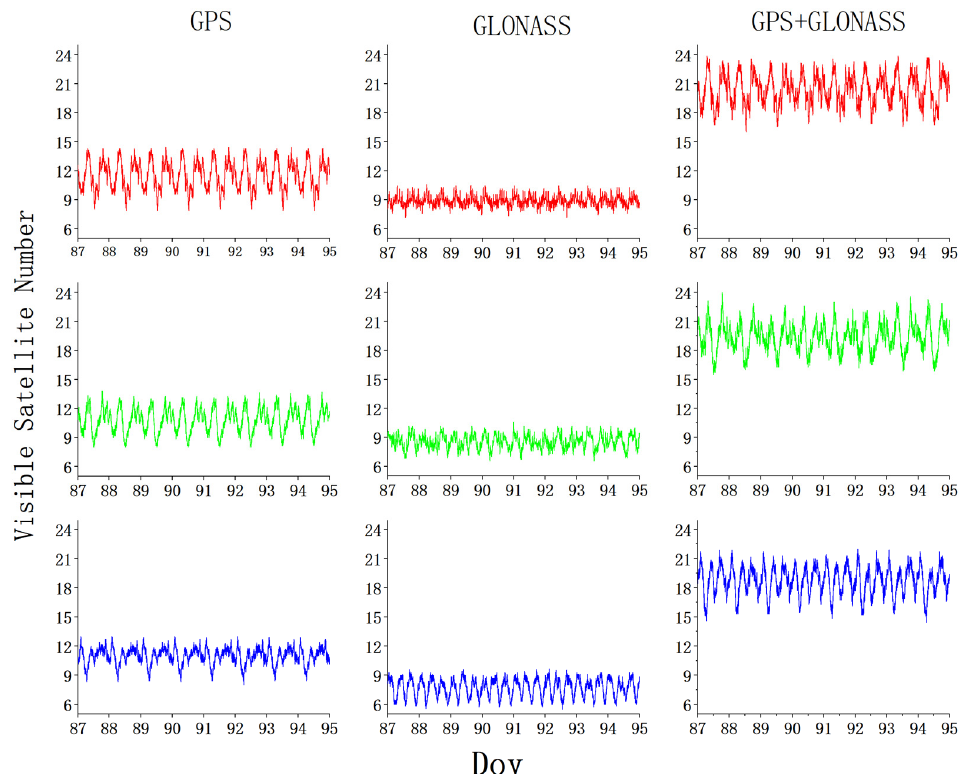
Figure 4. The average number of visible satellites of GPS, GLONASS, and GPS+GLONASS in the high (red), middle (green), and low (blue) latitude networks.